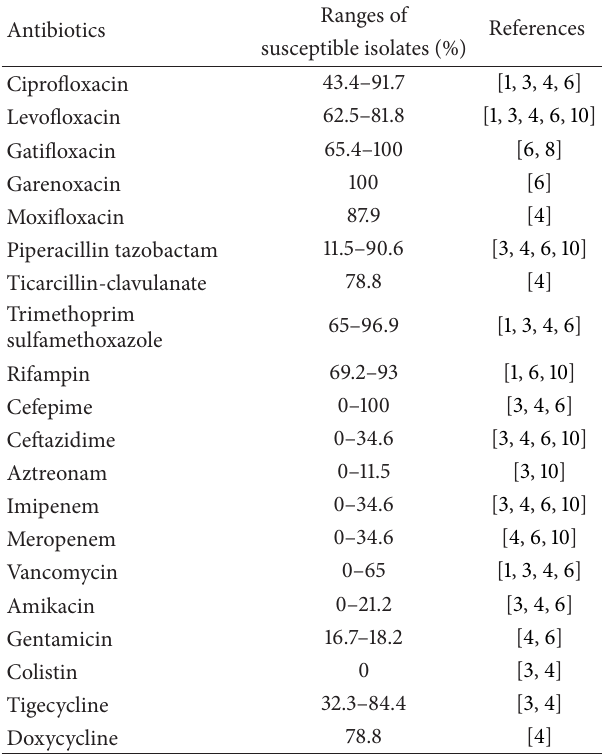
Table 1: Ranges of percentage of EM isolates susceptible to each antibiotic from 4 long-term clinical investigations [1, 3, 4, 6,